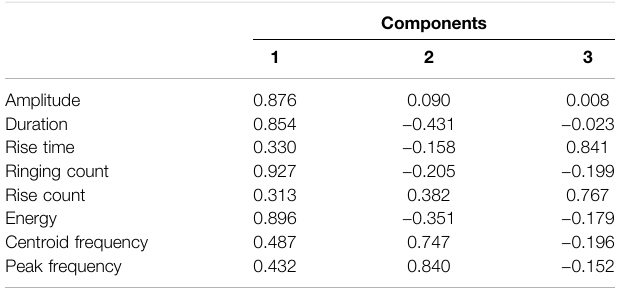
TABLE 4 | Correlation coef fi cient between principal components and characteristic parameters (sample 1).